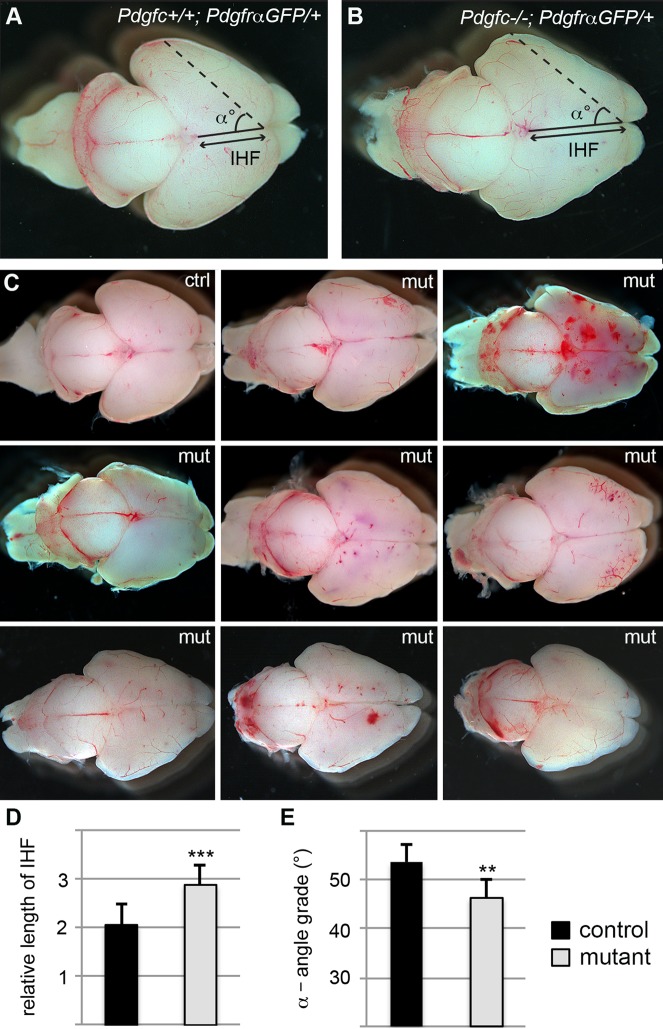
Phenotypic and anatomic variations in brains of newborn mice. Dorsal view of P0 brains from (A) Pdgfc+/+; PdgfraGFP/+ and (B) Pdgfc−/−; PdgfraGFP/+ mice. Filled line marks the interhemispheric fissure (IHF), the dotted line goes from the frontal end of the IHF to the most lateral point of the cerebrum. α is the angle between the two lines. (C) Examples of brains from newborn mice; one control (ctrl) and eight Pdgfc−/−; PdgfraGFP/+ (mut). Severity of both morphology and bleedings vary between the mutant mice. (D) Comparison of the length of the interhemispheric fissure in Pdgfc−/−; PdgfraGFP/+ (mut) and control mice. (E) Comparison of the angle α in Pdgfc−/−; PdgfraGFP/+ (mut) and control mice. Error bars show s.e.m.; **P<0.01, ***P<0.001.